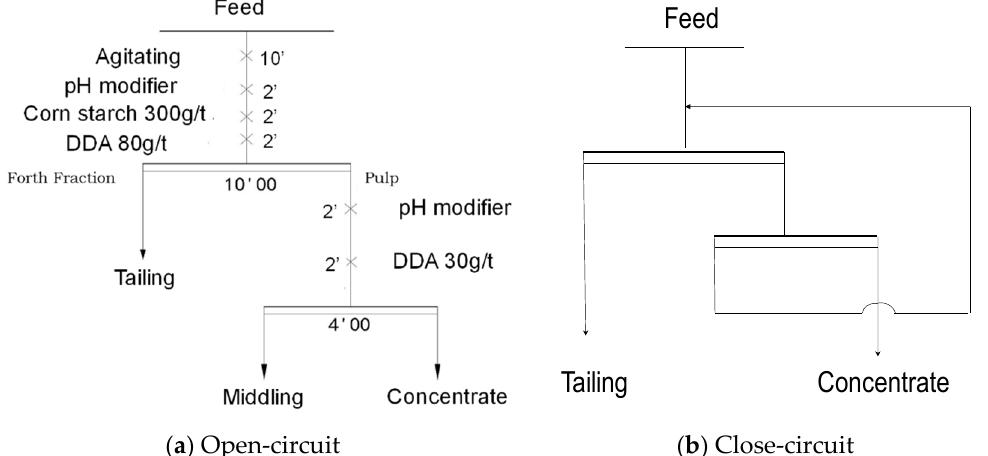
Figure 1. The open/closed-circuit flowsheet of the reverse cationic flotation of the iron ores in Yunnan, China: ( a ) Open-circuit, ( b ) Close-circuit.